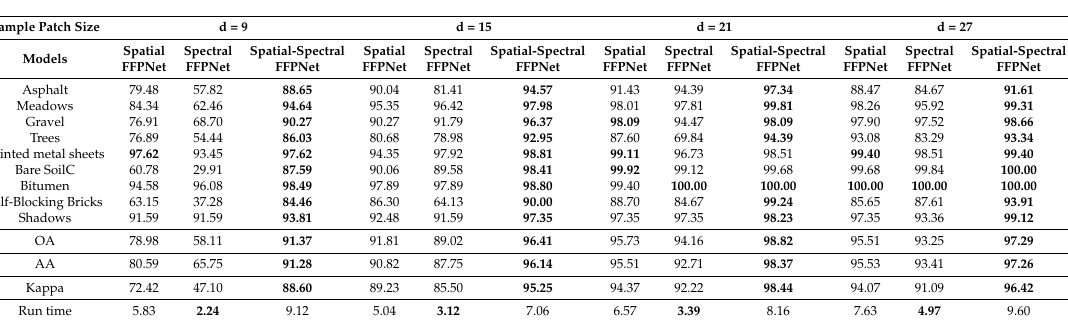
Table 16. Ablation study of the spatial FFPNet, spectral FFPNet, and spatial-spectral FFPNet with sample patch sizes of d = 9, 15, 21, and 27 and 100 samples per category on the UP dataset; the values in bold are the best. All results are the average of three runs with maximum epoch = 200 and mini-batch size =